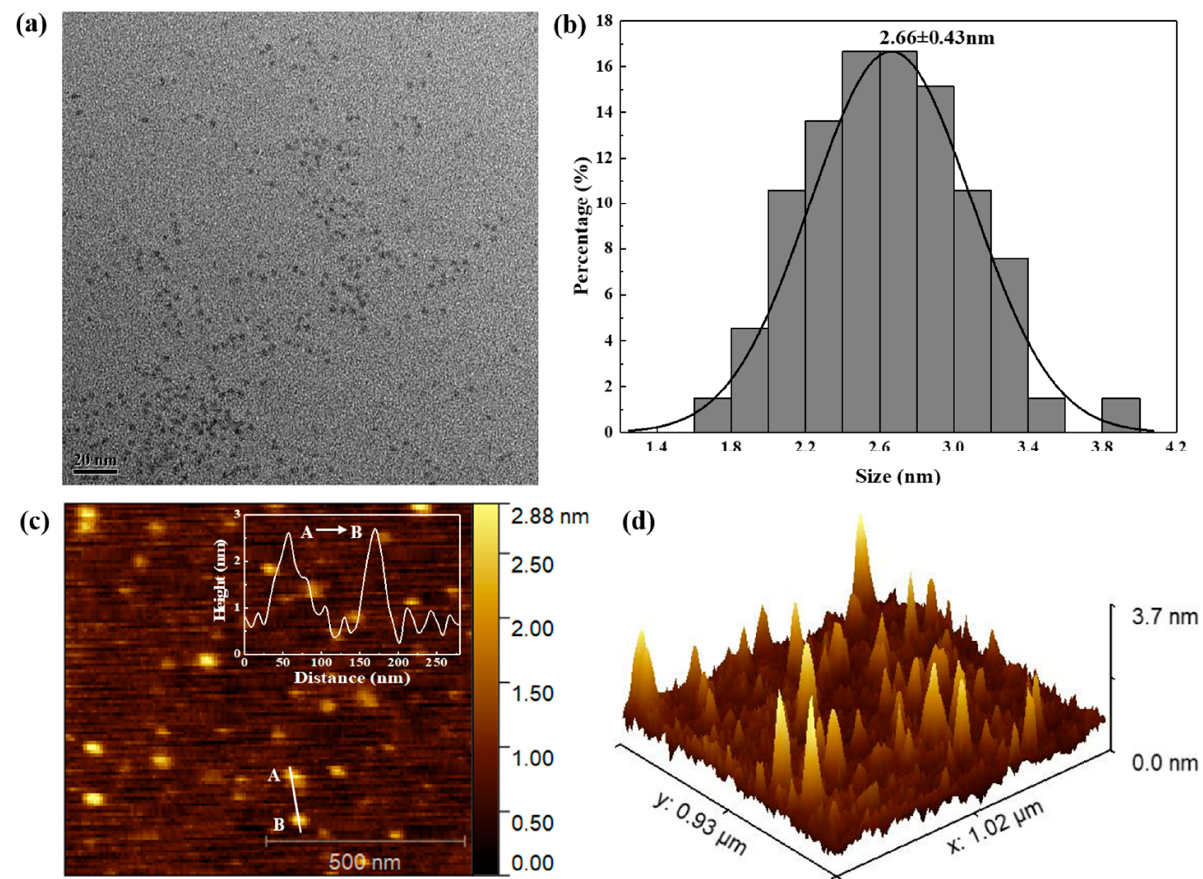
Figure 4. Morphology characterization of the N, S-PPI-CDs CDs. ( a ) TEM of N, S-PPI-CDs CDs; ( b ) statistical distribution of the sizes of the N, S-PPI-CDs; ( c ) AFM image of N, S-PPI-CDs (Inset: height distribution of N, S-PPI-CDs); ( d ) three-dimensional AFM image of the N, S-PPI-CDs.